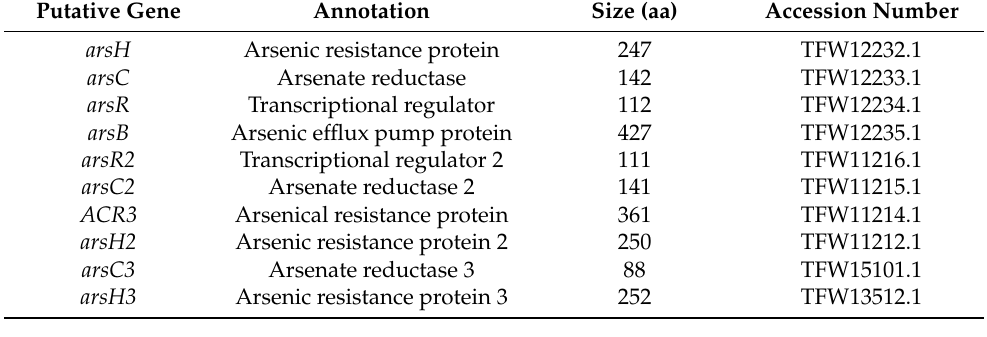
Table 3. List of arsenic resistance-related genes found in Brevundimonas sp. B10.